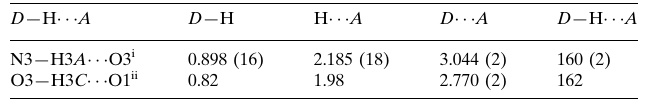
Hydrogen-bond geometry (A˚ , (cid:1)